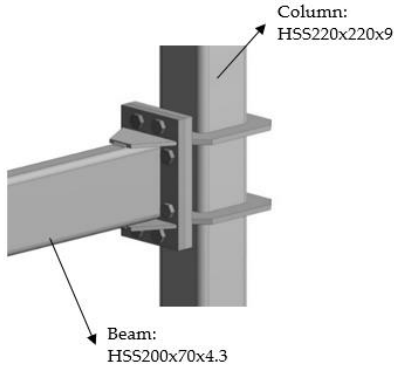
Figure 1. View of hollow structural section (HSS) moment connection .